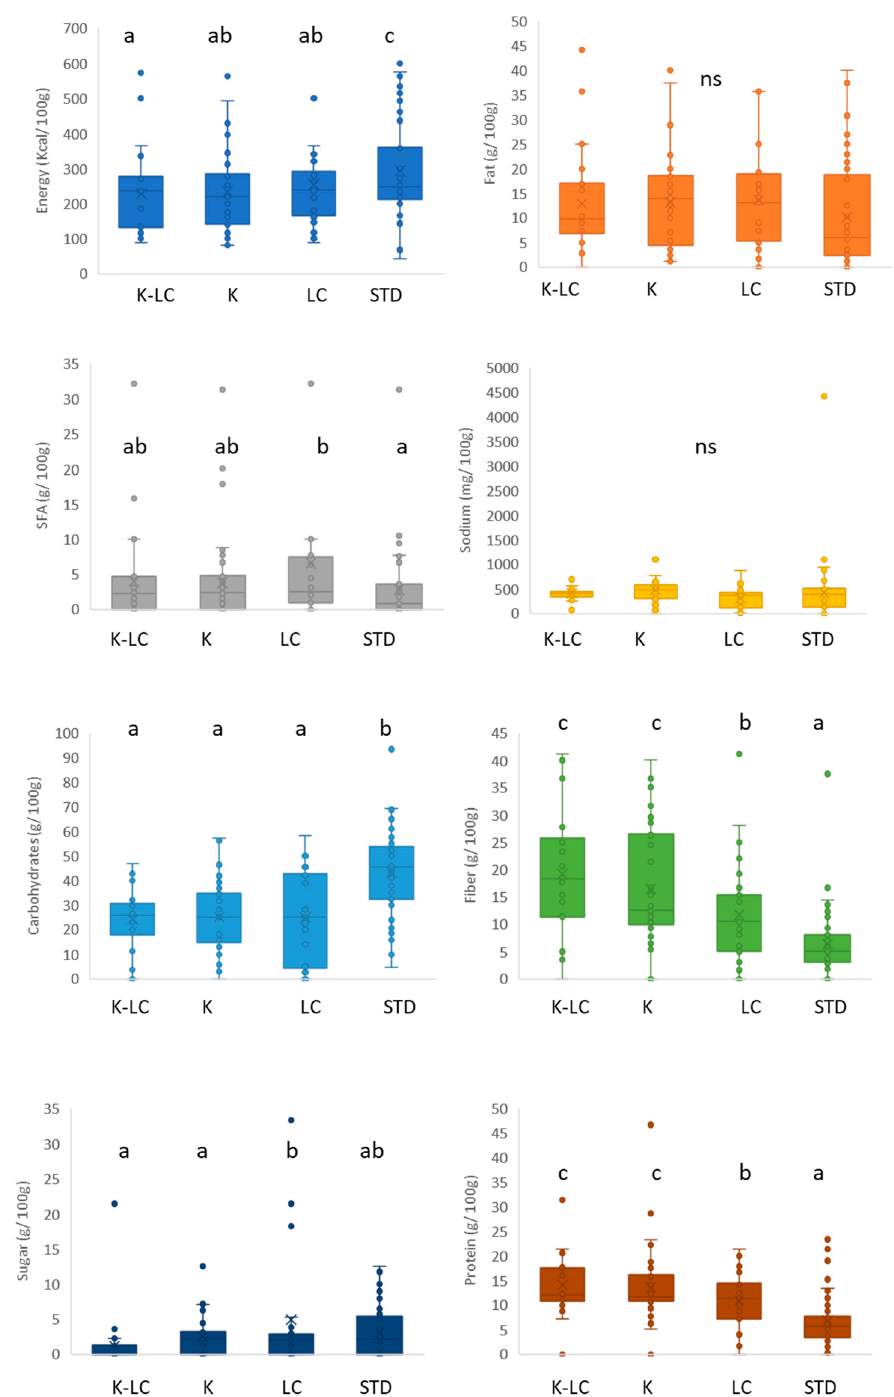
Figure 3. Nutritional composition of gluten-free bread products labeled ketogenic and/or low carb. K-LC: ketogenic and low carb; K: ketogenic; LC: low carb; STD: standard; different letters indicate significant difference at p < 0.05; ns: non-significant; the box-plot legend: the box is limited by the lower (Q1 = 25th) and upper (Q3 = 75th) quartile; the median is the horizontal line dividing the box; whiskers above and below the box indicate the 10th and 90th percentiles; outliers: are the points outside the quartile 10–90th